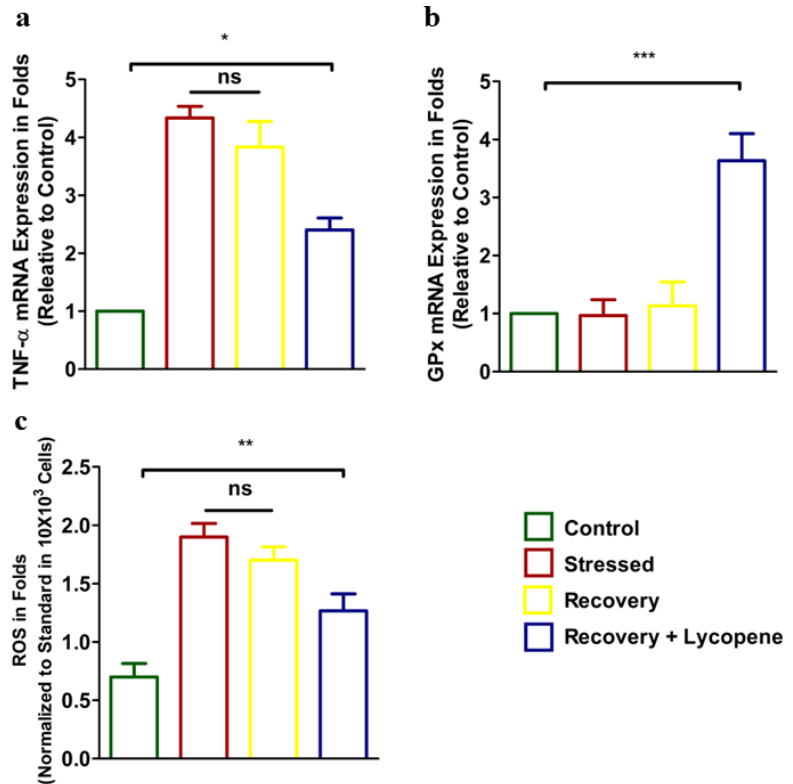
Figure 3. ( a ) mRNA expression of TNF- α . ( p < 0.0429) ( b ) mRNA expression of GPx ( p < 0.0072). ( c ) Cytosolic ROS levels ( p < 0.0009) in control, stressed, recovery and recovery + Lycopene treated cells. (* p < 0.05, ** p < 0.01, *** p < 0.001).